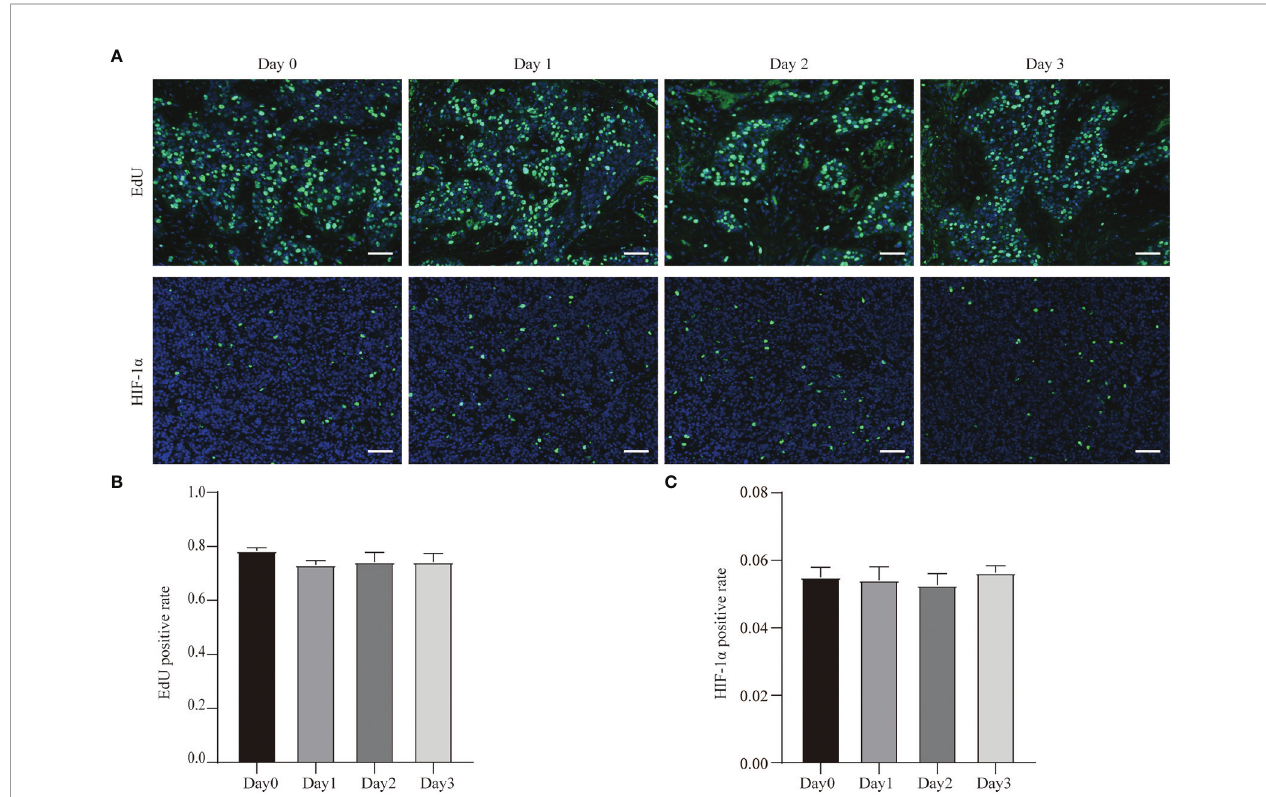
FIGURE 4 | EdU incorporation and hypoxia of GC cell during the culture. (A) EdU incorporation of Case29 before and after 3 days of culture, scale bar, 50 m m, and HIF-1 a staining of Case30 before and after 3 days of culture, scale bar, 50 m m. (B) Quantitative analysis of EdU in Case29. (C) Quantitative analysis of HIF-1 a in